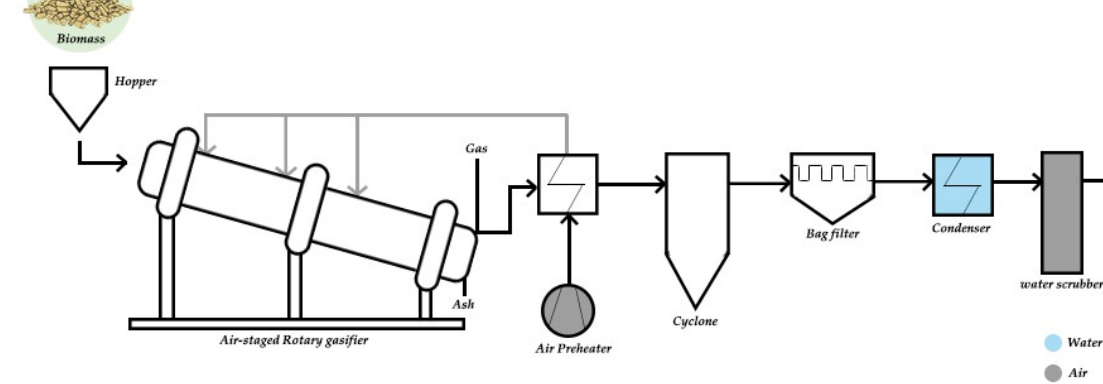
Figure 4. Rotary kiln reactor.